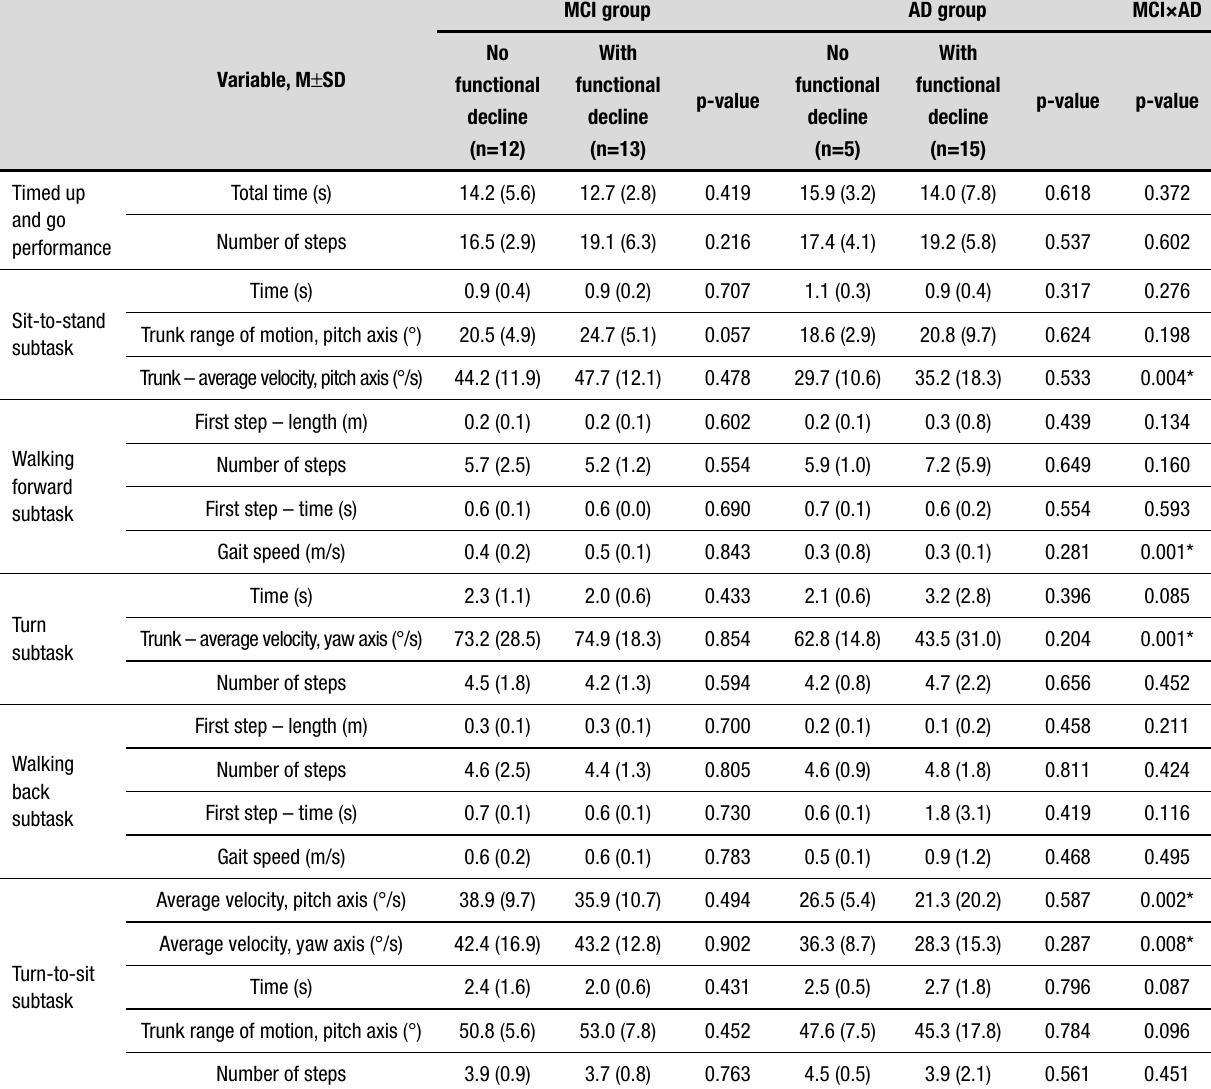
Table 2. Timed up and go performance and its subtasks.